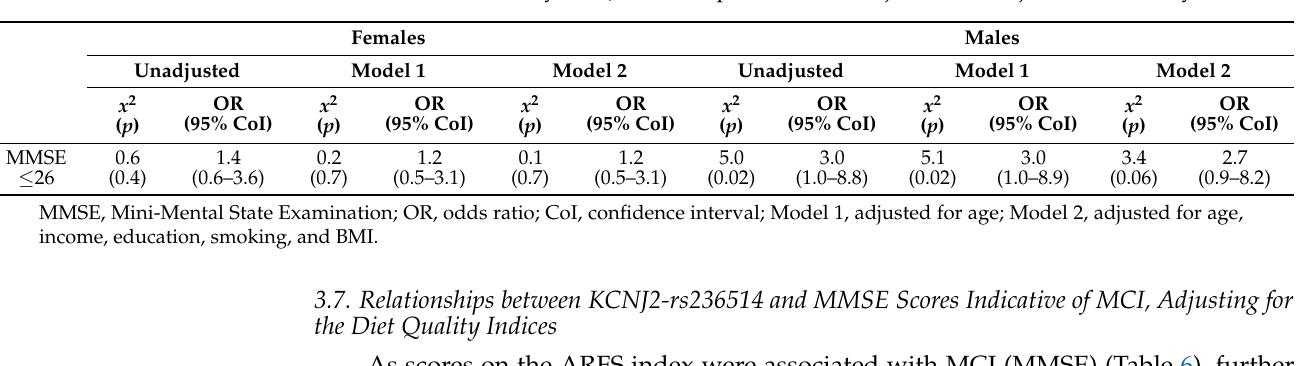
Table 9. Odds of MMSE scores indicative of MCI by KCNJ2 -A allele presence in unadjusted and adjusted models, by sex.